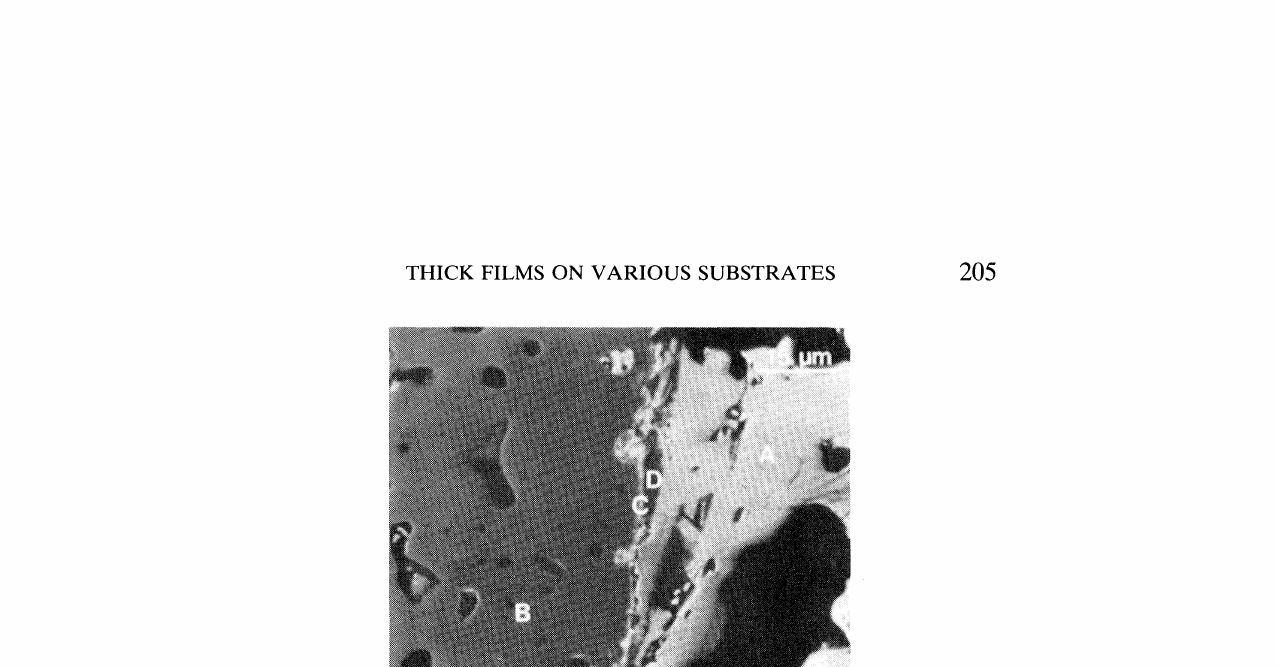
FIGURE 7 Cross-sectional SEM view of a porous 123 superconducting thick film (A) on an MSZ substrate (B). The light narrow zone (C) between the thick film and the substrate is the compound BaZrO3, the dark contrast outside that zone comes from CuO